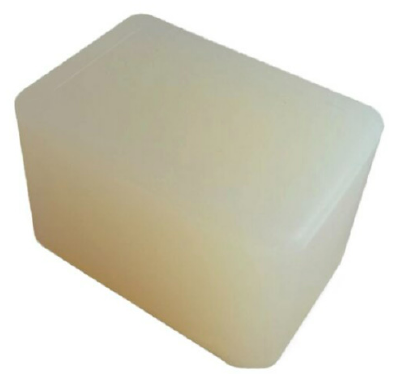
Figure 3. Ballistic soap [25].